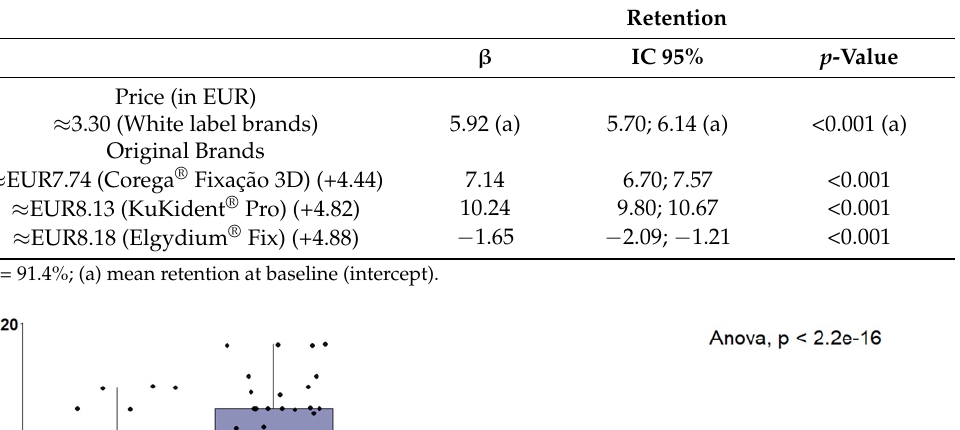
Table 5. Evaluation of mean retentive ability gains by mean price increase.